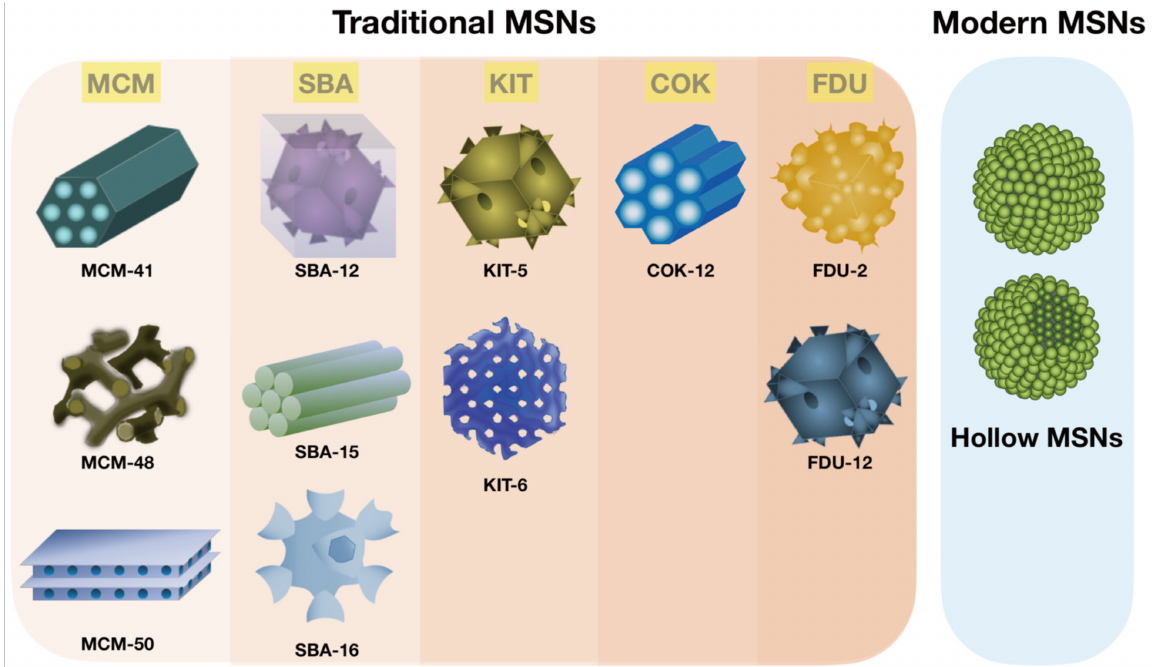
Figure 2. The construction of MSNs via different strategies. Schematic classification of material-based traditional MSNs and modern hollow